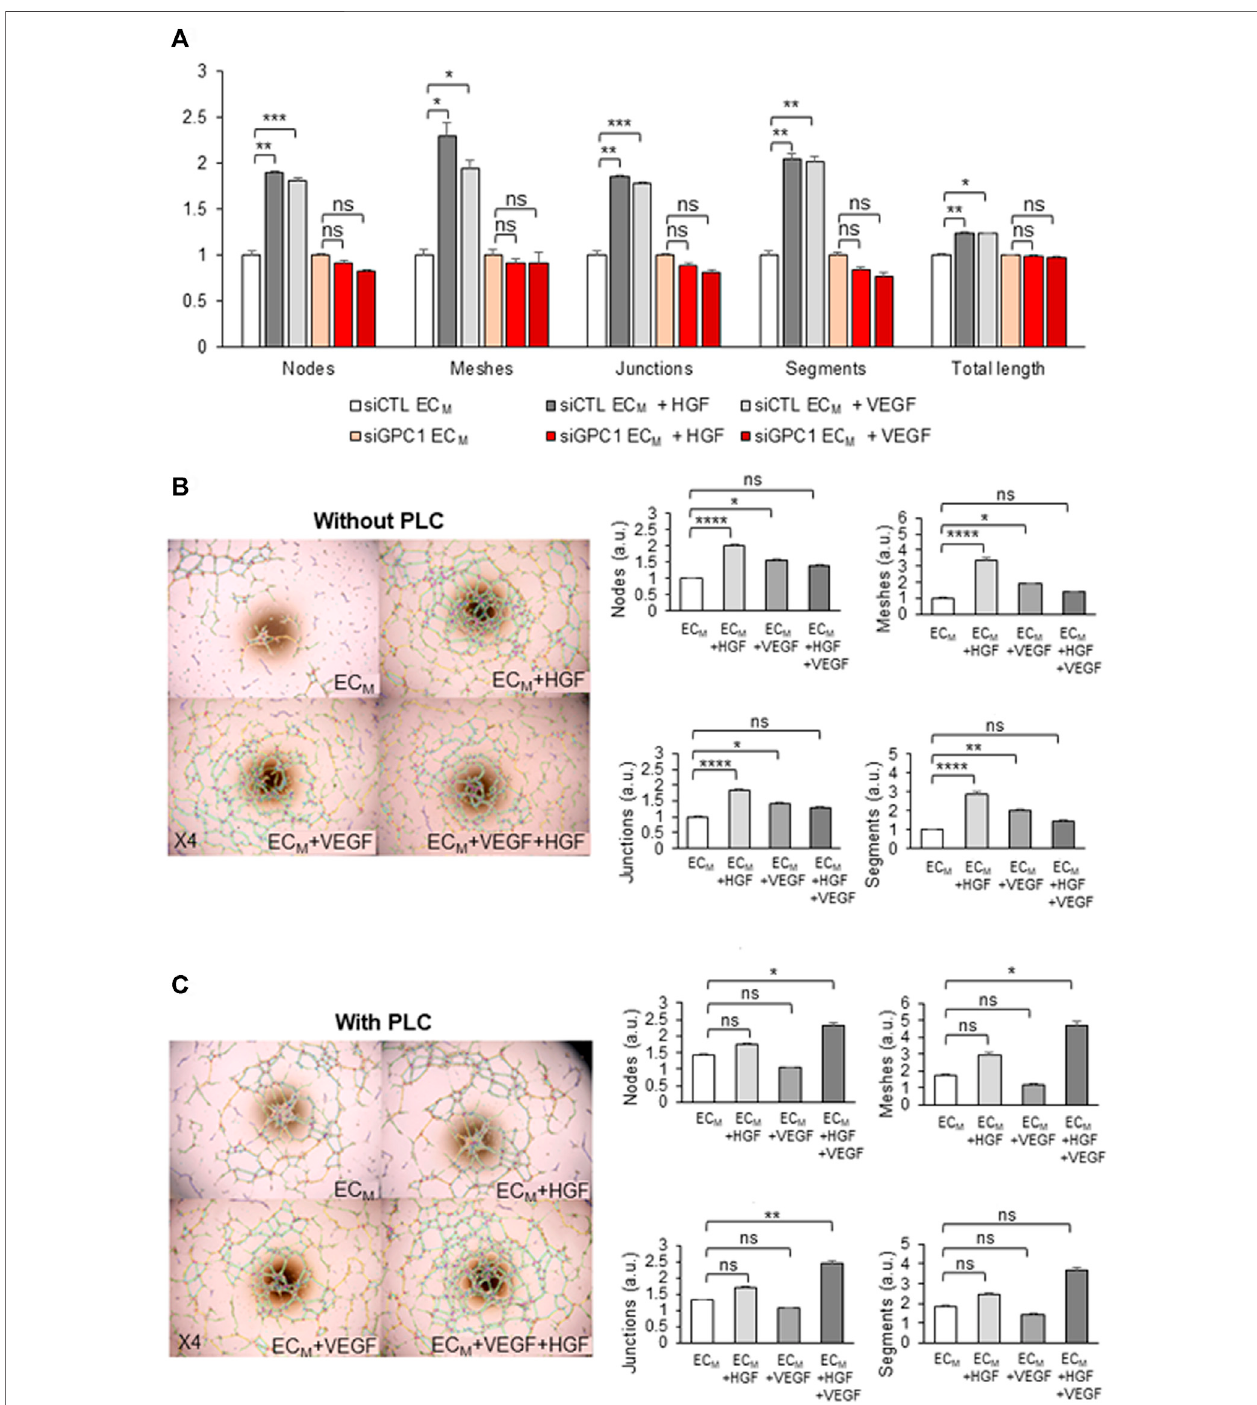
FIGURE 9 | KORS regulate HDMEC pseudotube formation in a GPC1-dependent manner via HGF/c-Met and VEGF/VEGFR2. (A) Pseudotube formation of non- transfected or transfected (siCLT or siGPC1) HDMEC after 5 h in EC M without or with VEGF or HGF were performed and the number of nodes, meshes, junctions, segments, and the total length were calculated and expressed as the mean ± SEM, n (cid:2) 4 replicates and two independent experiments. (B,C) Effect of HGF, VEGF and the combination of both growth factors on HDMEC pseudotube formation without (B) or with (C) 0.5 U/mL PLC treatment for 1 h at 37 ° C. The number of nodes, meshes, junctions and segments was quanti fi ed. The results are expressed as the mean ± SEM in the right panel, n (cid:2) 6 replicates and two independent experiments.